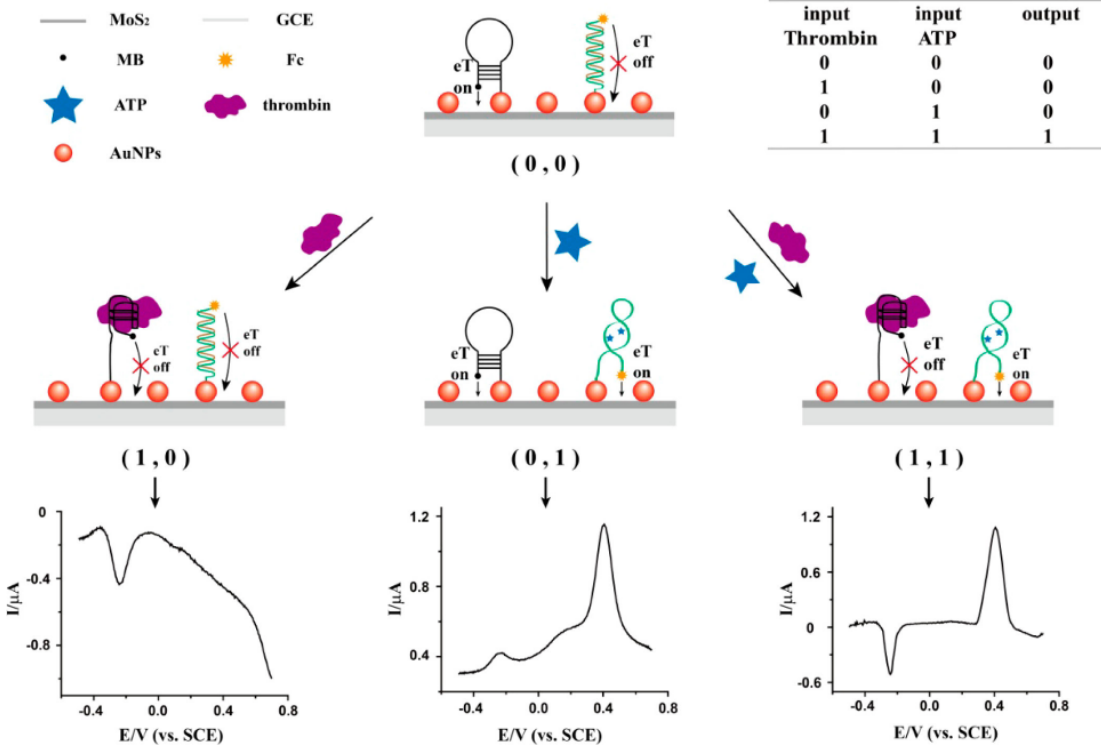
Figure 12. Schematic description of the MoS 2 -Based AND logic gate for determination of ATP and thrombin. Reprinted with permission from Ref. [78] . Copyright 2016, ACS.